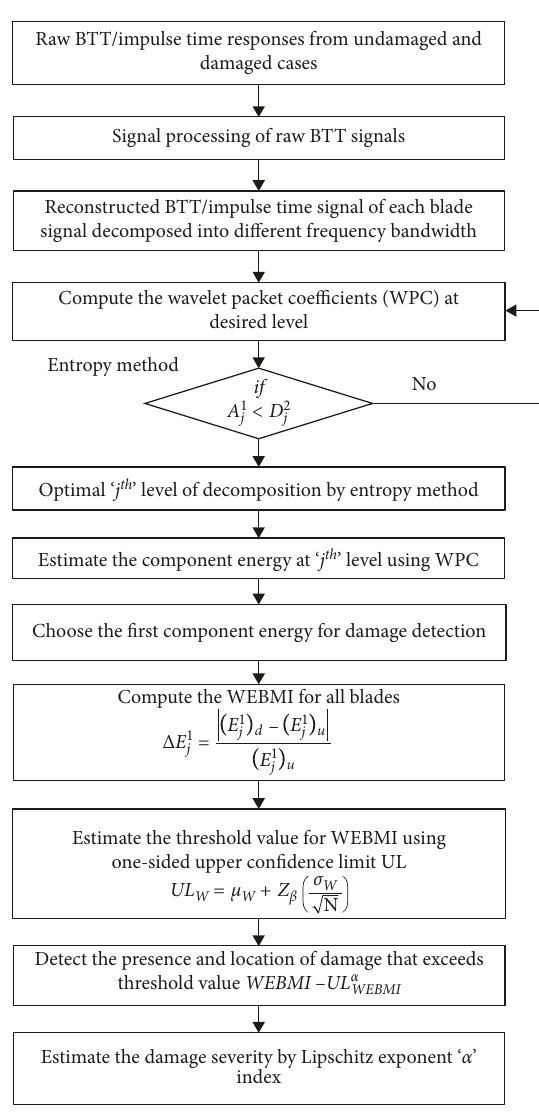
Figure 1: Damage detection